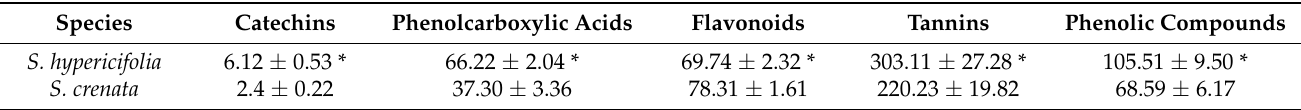
Table 1. Contents (mg/g of dry extract) of phenolic compounds in extracts from the two Spiraea species. Species